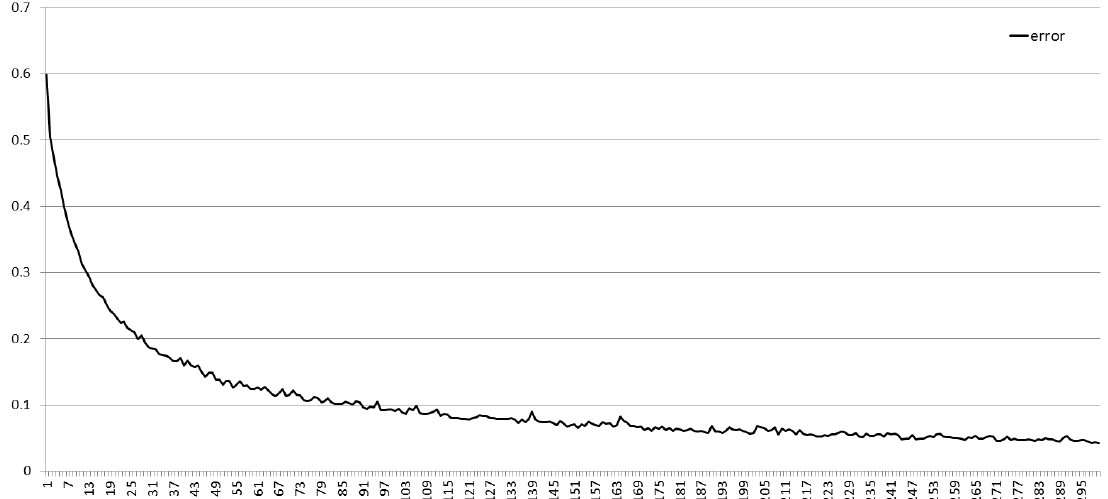
Figure 2. Error change of different the number of